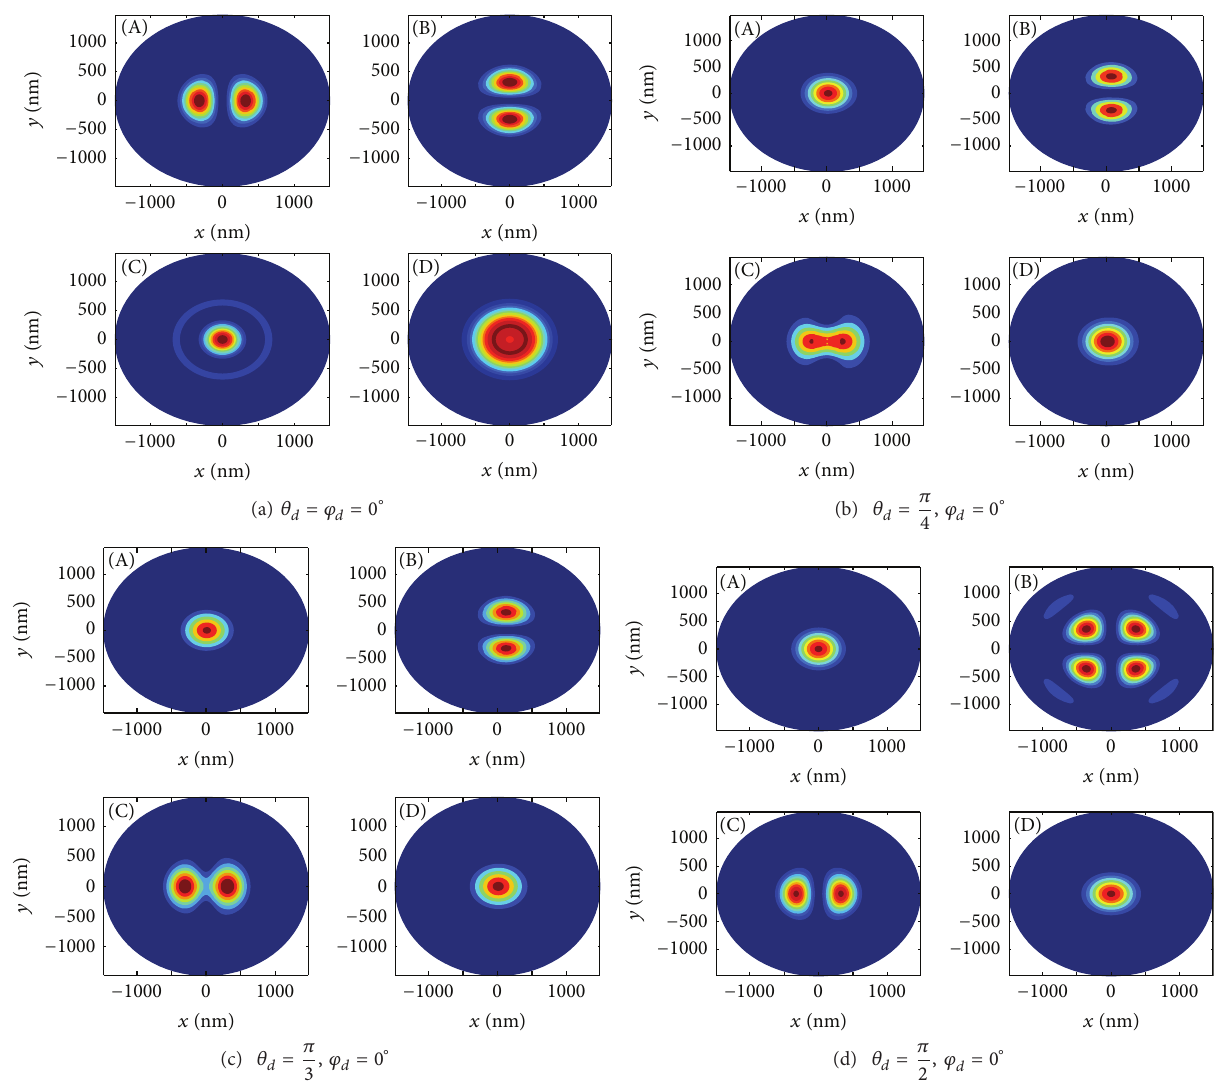
Figure 4: Intensity distribution of emission by a dipole with different orientation angles in the focal plane in image space. (A), (B), and (C) are the component intensities of |𝐸 𝑎𝑥 | 2 , |𝐸 𝑎𝑦 | 2 , and |𝐸 𝑎𝑧 | 2 respectively; (D) is the total intensity of |𝐸 𝑎𝑥 | 2 + |𝐸 𝑎𝑦 | 2 + |𝐸 𝑎𝑧 | 2